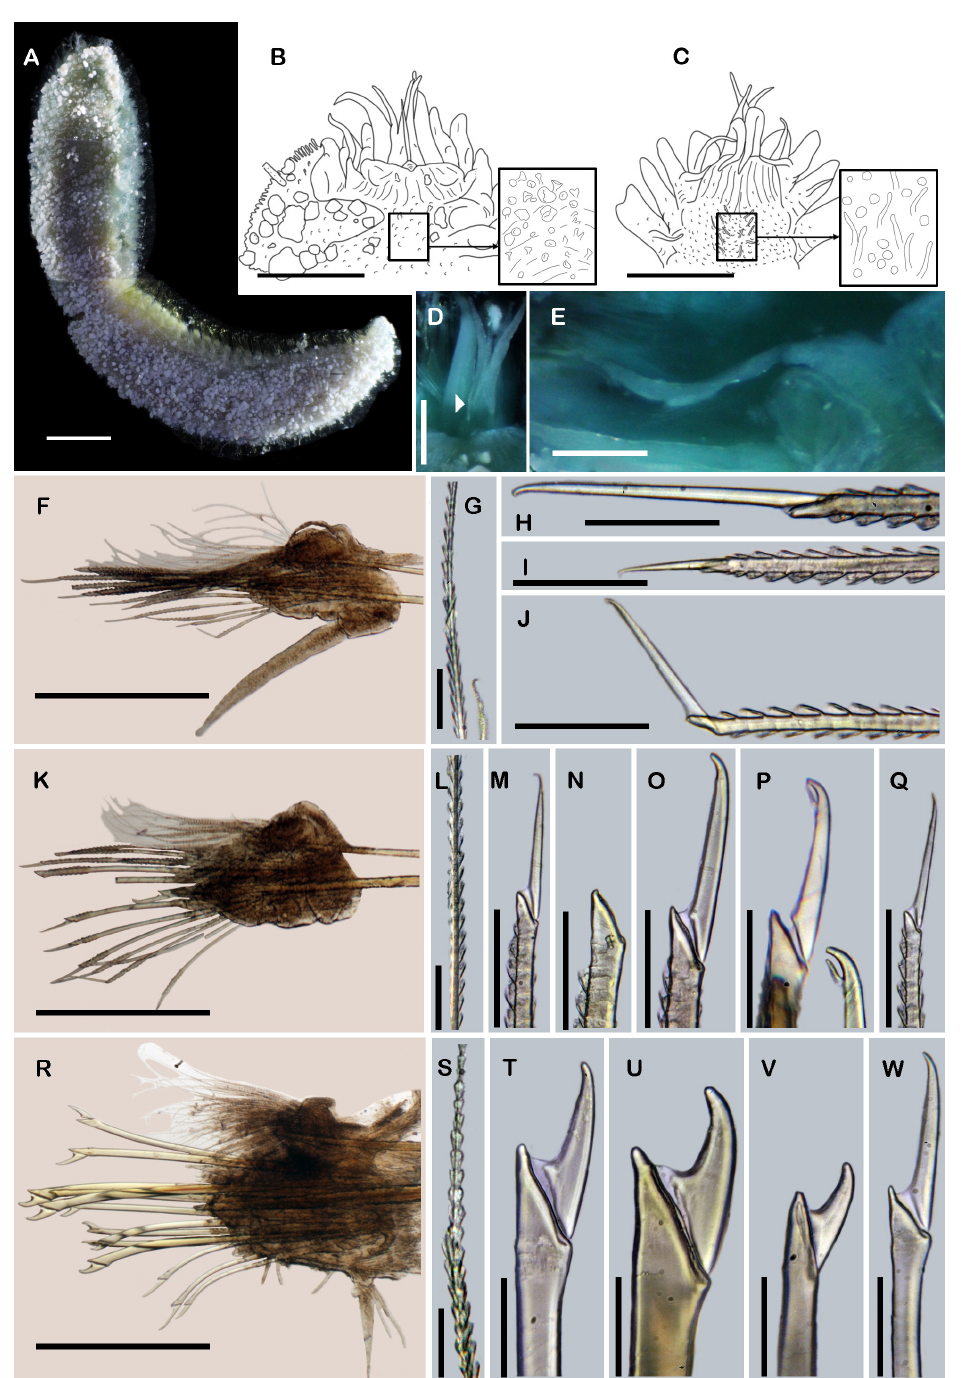
Fig. 19. Pelogenia capitata sp. nov., holotype (ECOSUR 291). A . Complete worm, dorsal view. B . Anterior end, dorsal view (insert: dorsal papillae). C . Anterior end, ventral view (insert: ventral papillae). D . Close-up of B, arrowhead indicates median antenna. E . Right dorsal cirrus from segment III. F . Right parapodium from segment II. G . Notochaeta from same. H . Unit A. I . Unit C. J . Unit D. K . Right parapodium from segment III. L . Notochaeta from same. M . Unit A. N . Unit B. O . Unit C. P . Subunit 1. Q . Unit D. R . Right parapodium from segment 25. S . Notochaeta from same. T . Unit A. U . Unit B. V . Unit C. W . Unit D. Scale bars: A = 2 mm; B–C, F, K, R = 500 μm; D–E = 200 μm; G, L, S = 40 μm; H–J, M–Q, T–W = 50 μm.